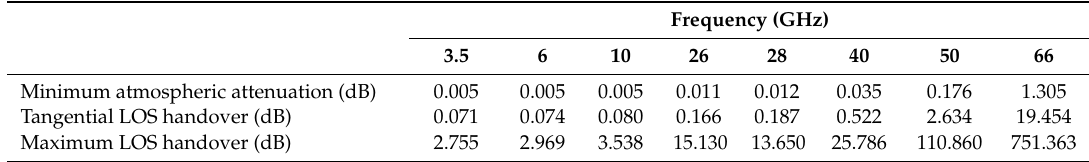
Table 1. Signal dynamic ranges due to atmospheric gaseous attenuation only for SB @ 20 km high and cruise altitude of 11 km high.